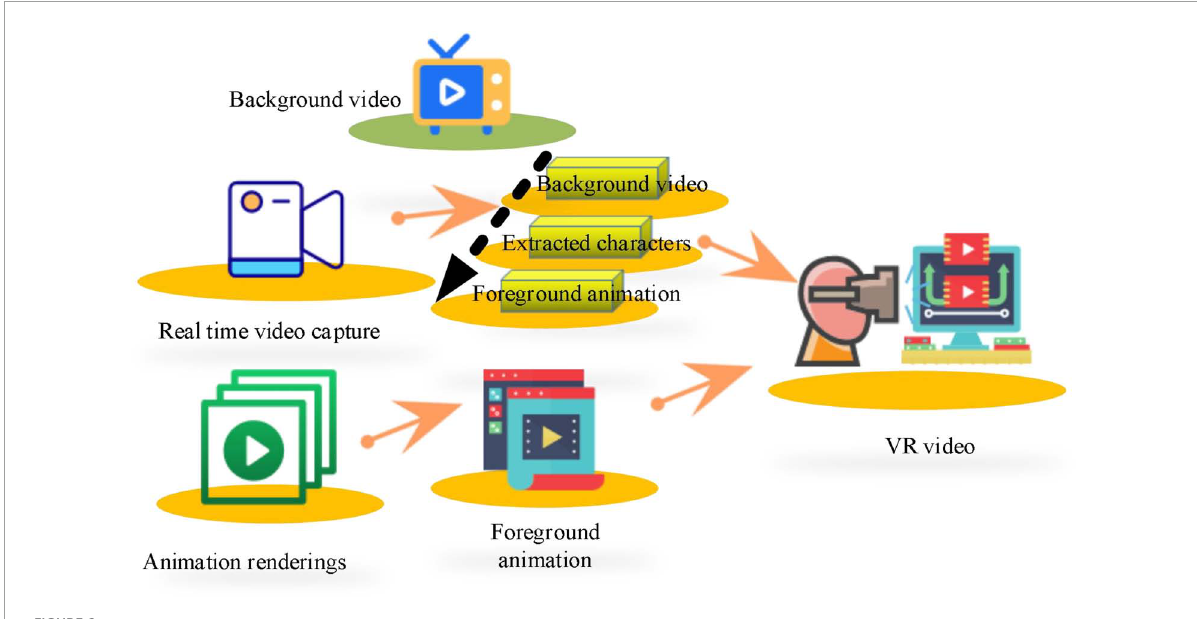
FIGURE6 Video composition diagram.